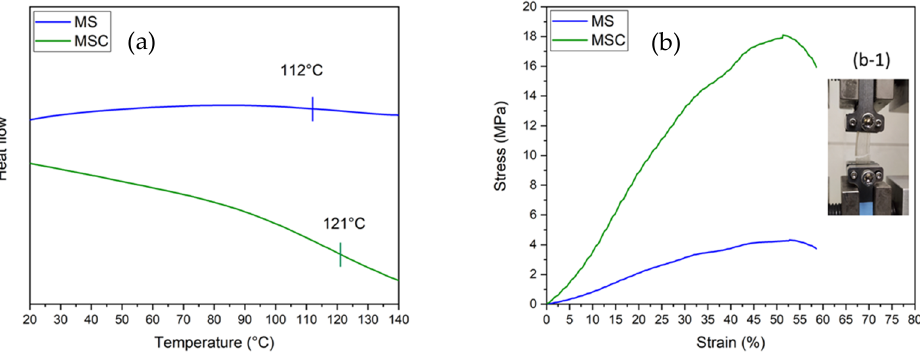
Figure 1. ( a ) FTIR spectra of Starch (S) and methacrylated starch (MS); ( b ) Evaluation of gel content after different UV- curing times for MSC films.